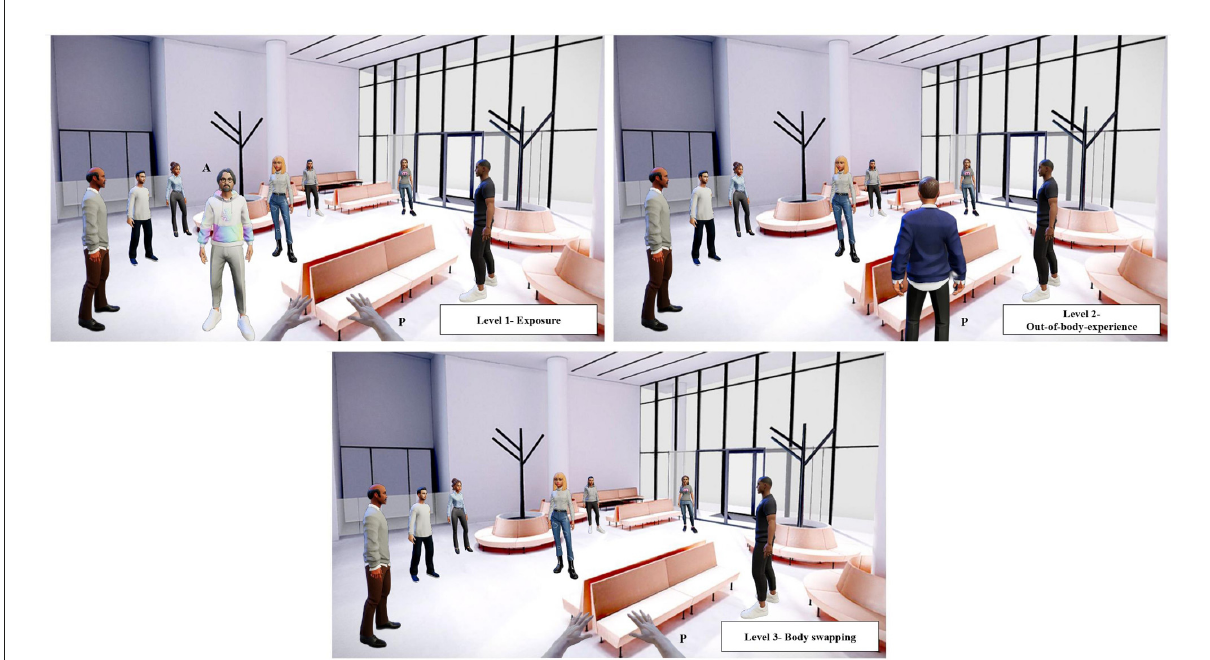
FIGURE2 Hypothetical scenarios for levels 1, 2, and 3. In level 1 the patient (P) encourages the virtual avatar (A) to cope with the distress experienced in a social context where other people look at them and make the avatar feel not at ease. In level 2 the patient (P) now experiences the distressing situation from an external perspective. In level 3 the patient (P) embodies the virtual avatar and experiences in first-person the